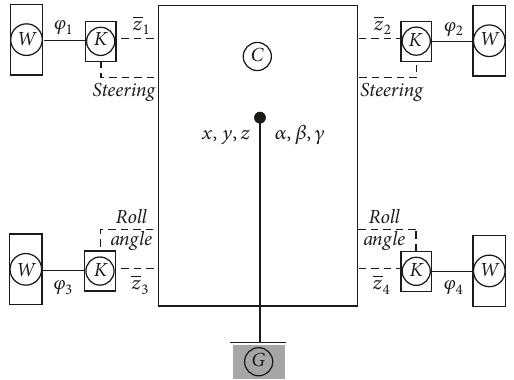
Figure 3: Dynacar multibody formulation [20]